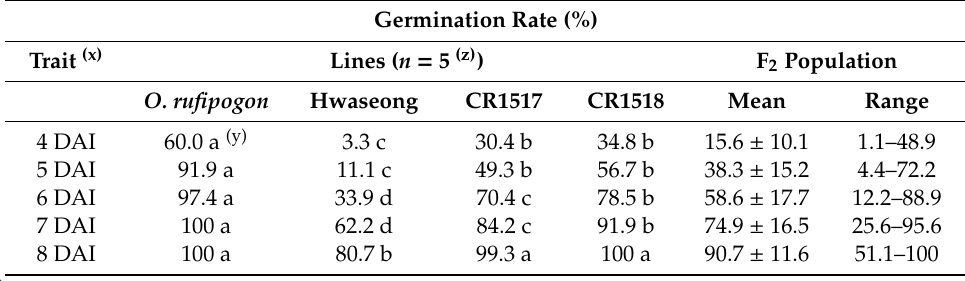
Table 1. Mean germination rates in O. rufipogon , Hwaseong, two introgression lines, and F 2